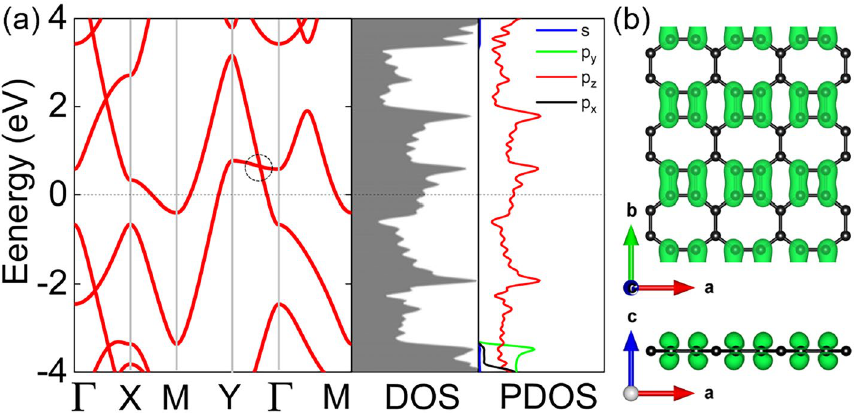
Figure 3. ( a ) Band structure (left panel), density of states (middle), and projected density of states (right panel) of biphenylene; ( b ) the partial charge density of biphenylene, the value of the isosurface is set to 0.01 e Å -3 .